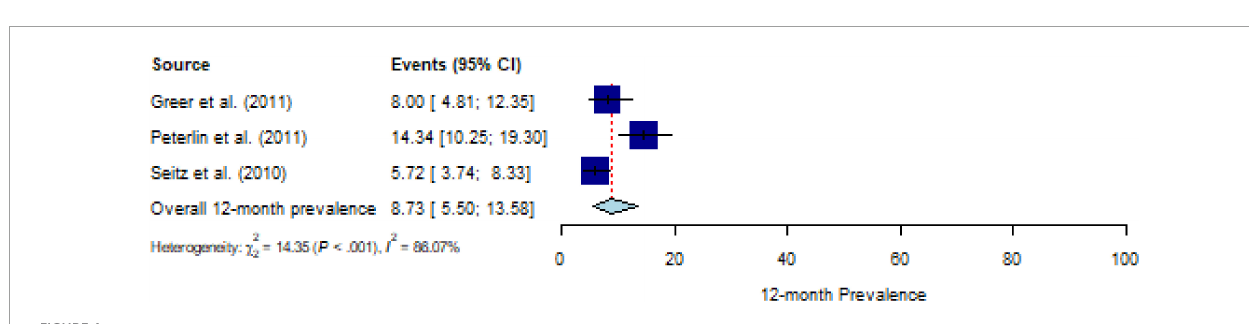
different CD on PTSD and PTSS, with consideration of symptom severity